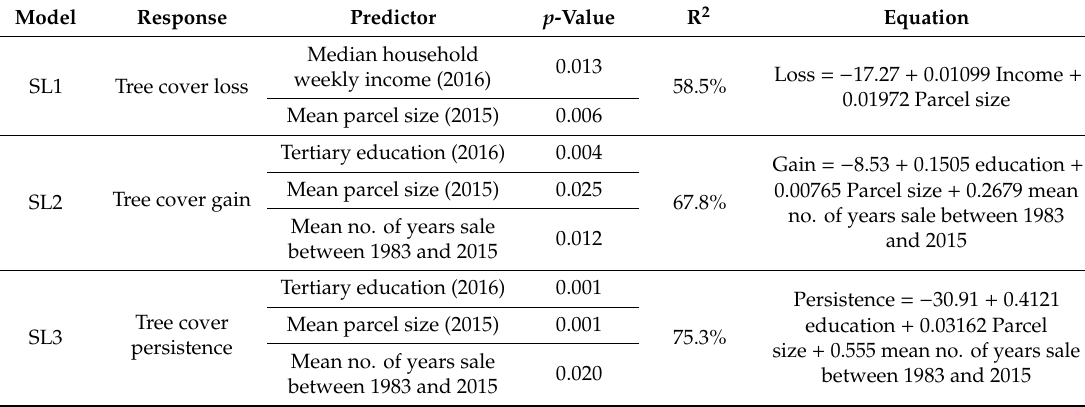
Table 4. Best fit multiple regression model to predict the tree cover loss, gain and persistence in patch